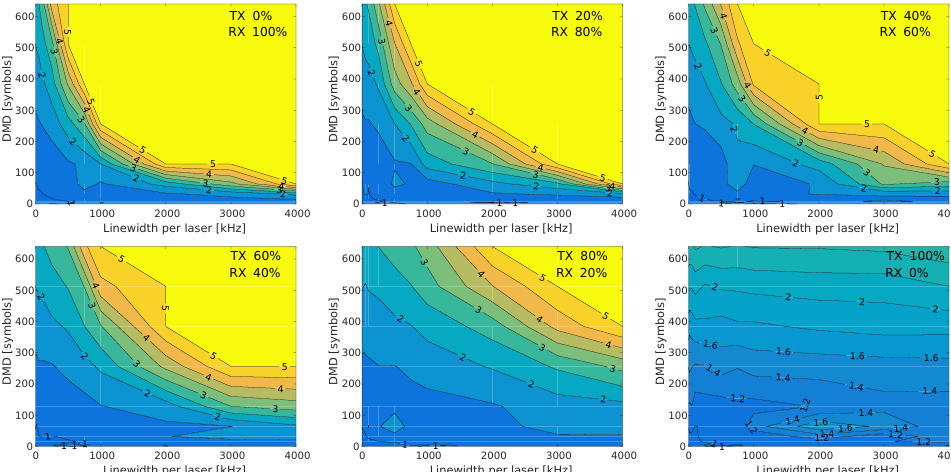
Figure 9. OSNR penalties in dB, computed at a BER of 10 − 4 , for QPSK modulation and model B for several distributions of the phase noise between the transmitter and receiver lasers.